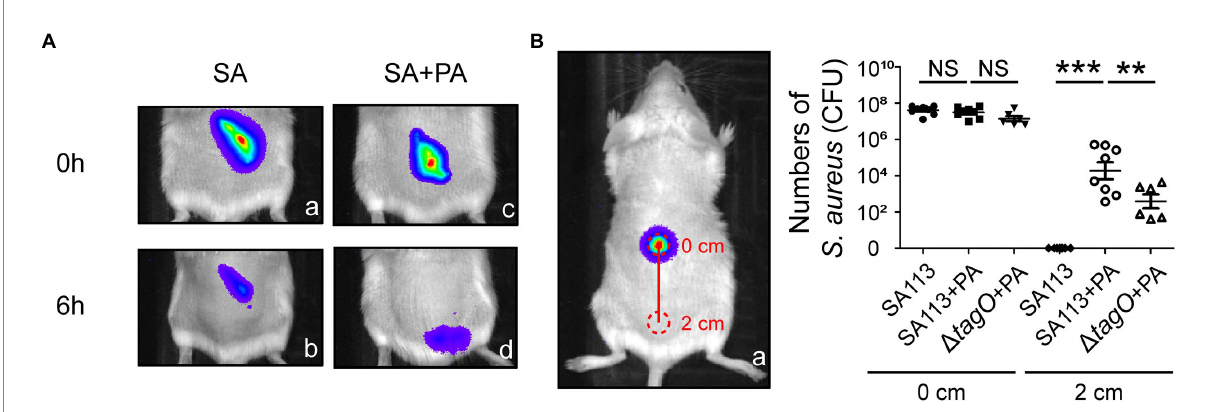
FIGURE 5 Movement of Staphylococcus aureus mediated by Pseudomonas aeruginosa in mice. (A) Mice were injected subcutaneously with bioluminescent S. aureus CGL1190 (SA) alone (a,b) or SA mixed with P. aeruginosa PAO1 (SA + PA) (c,d) . Bioluminescence of SA in mice was observed and imaged at 0 and 6 h post-inoculation using an IVIS instrument. The images shown are representative of each group ( n = 8 per group). (B) After observation, the mice were sacrificed, and skin tissue at areas of 0 and 2 cm (red circles) was removed. The number of S. aureus recovered from the skin tissues was determined. Data are presented as the mean of the results from each group and were analyzed statistically using One-way ANOVA. Error bars indicate the standard deviations. Significant differences are denoted as follows: ** indicates p < 0.01, and *** indicates p < 0.001. NS, no